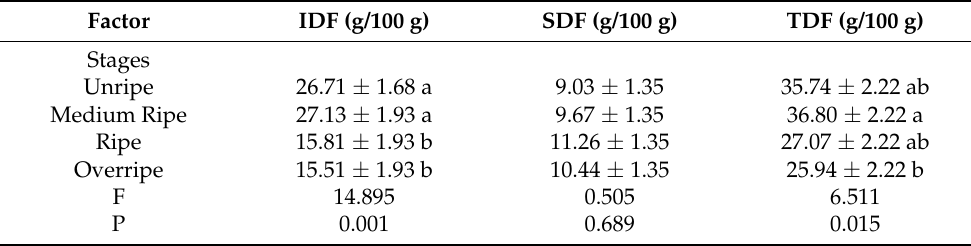
Table 3. ANOVA for insoluble dietary fibre (IDF), soluble dietary fibre (SDF), and total dietary fibre (TDF) expressed in dry weight and considering the four development stages of H. edulis “ubajay” harvested in Moreno (Buenos Aires). Values represent means ± standard error. Factor IDF (g/100 g) SDF (g/100 g) TDF (g/100